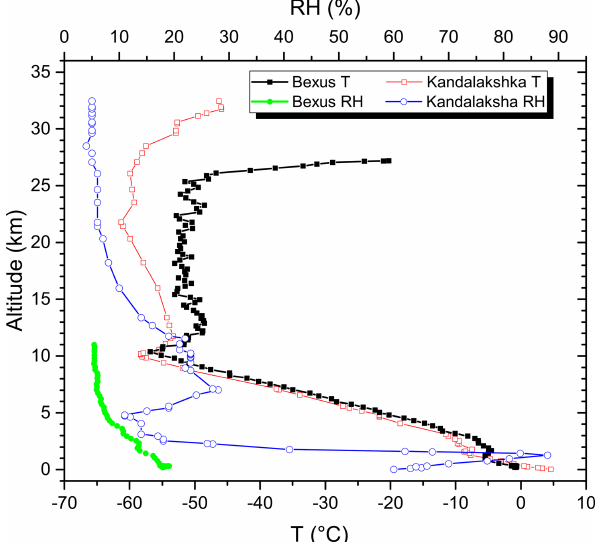
Figure 1. Vertical profiles of ambient external temperature (T) and relative humidity (RH) as measured along the BEXUS18 strato- spheric flight on 10 October 2014 and by the radiosounding from the Kandalashka station (67.15 ◦ N, 32.35 ◦ E) on 11 October 2014 at 00:00UTC.